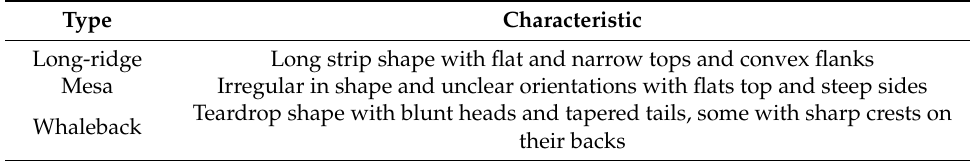
Table 1. Characteristics of the three main types of